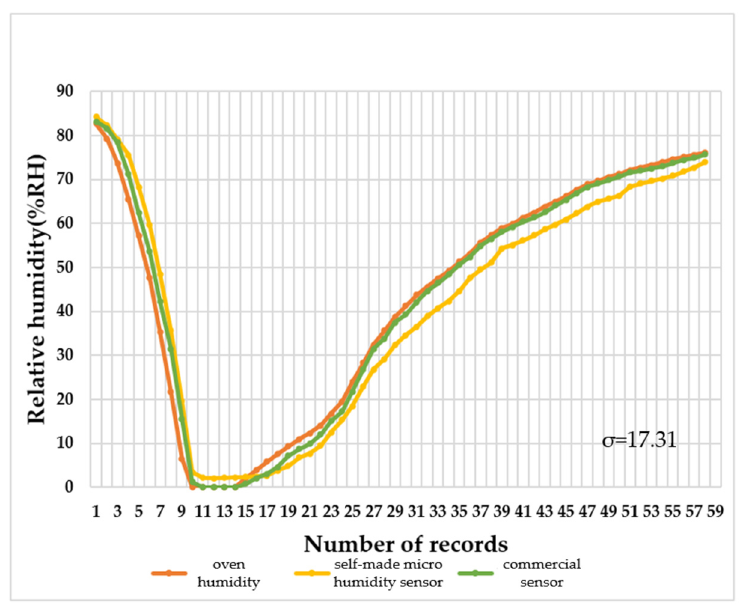
Figure 11. Monitoring data on humidity.